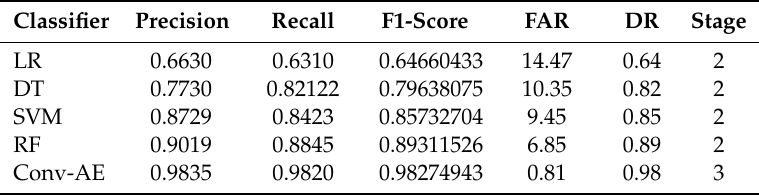
Table 7. Performance of the proposed ID